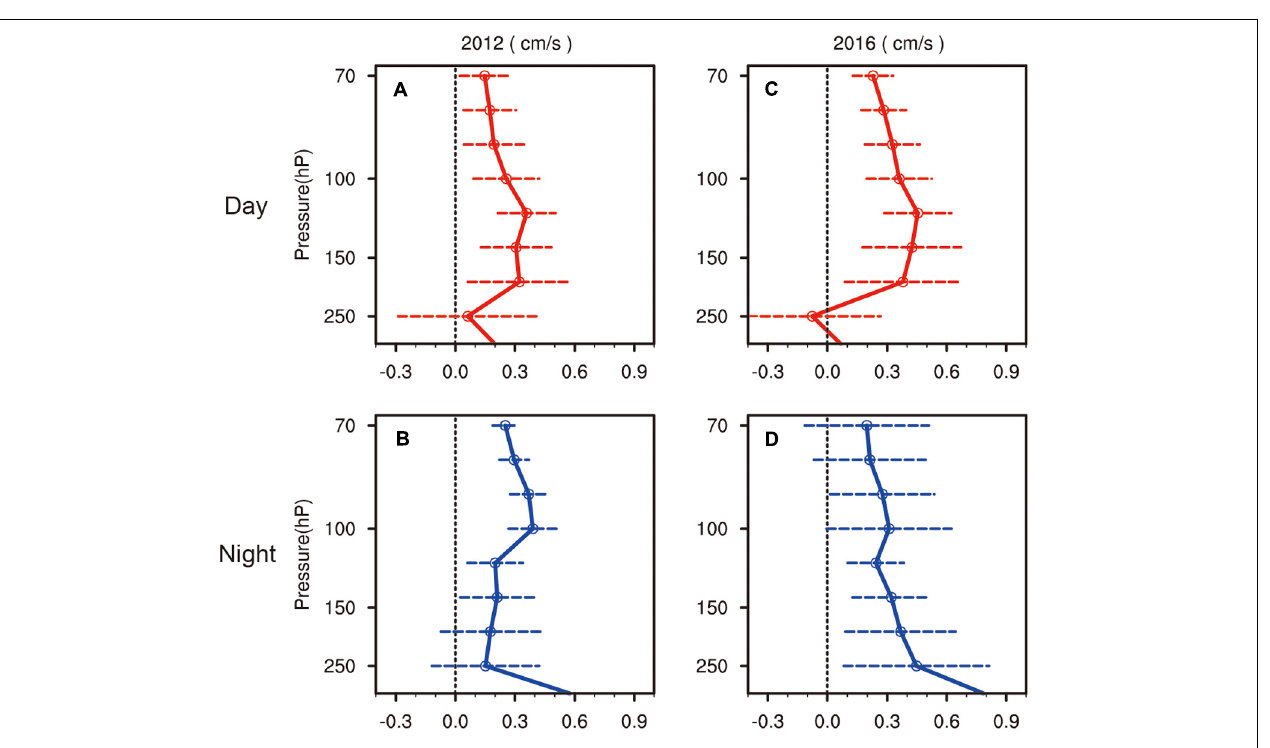
Frontiers in Earth Science |